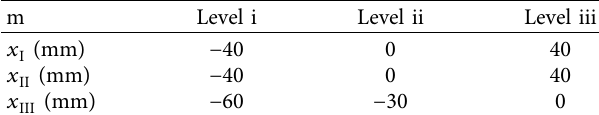
Figure 3: Projected effect of the first four modes of vibration on the flexible shafting. (a) First mode. (b) Second mode. (c) Third mode. (d) Fourth mode. Table 4: Orthogonal test level factors of the supports’ positions.